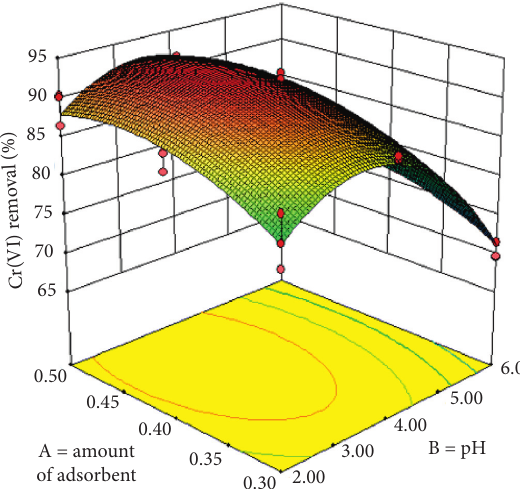
Figure 9: Adsorption isotherms for Cr(VI) removal onto orga- nobentonite at different